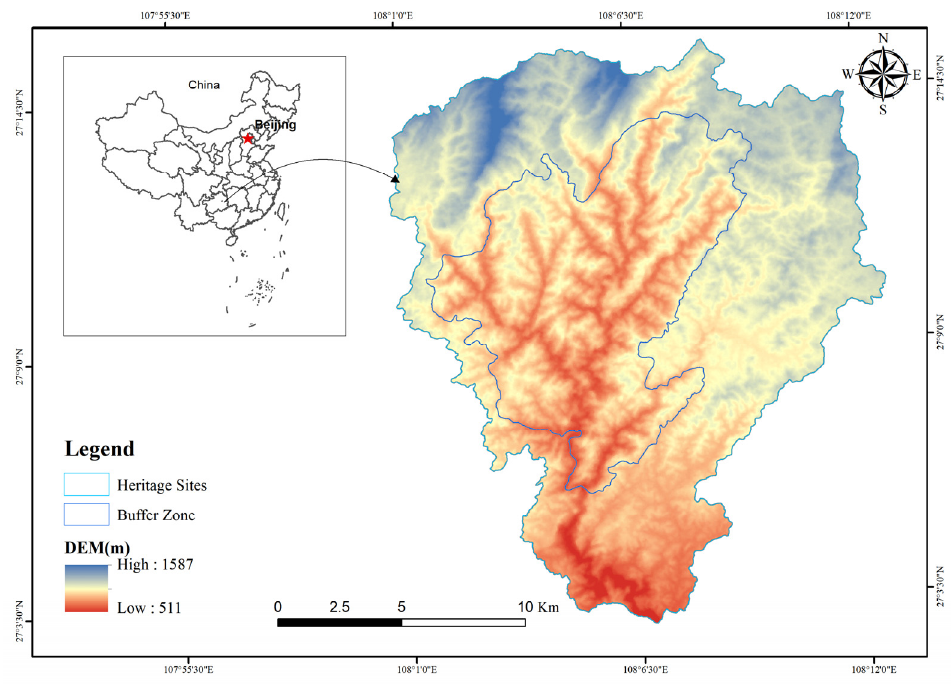
Figure 1. Location of the study